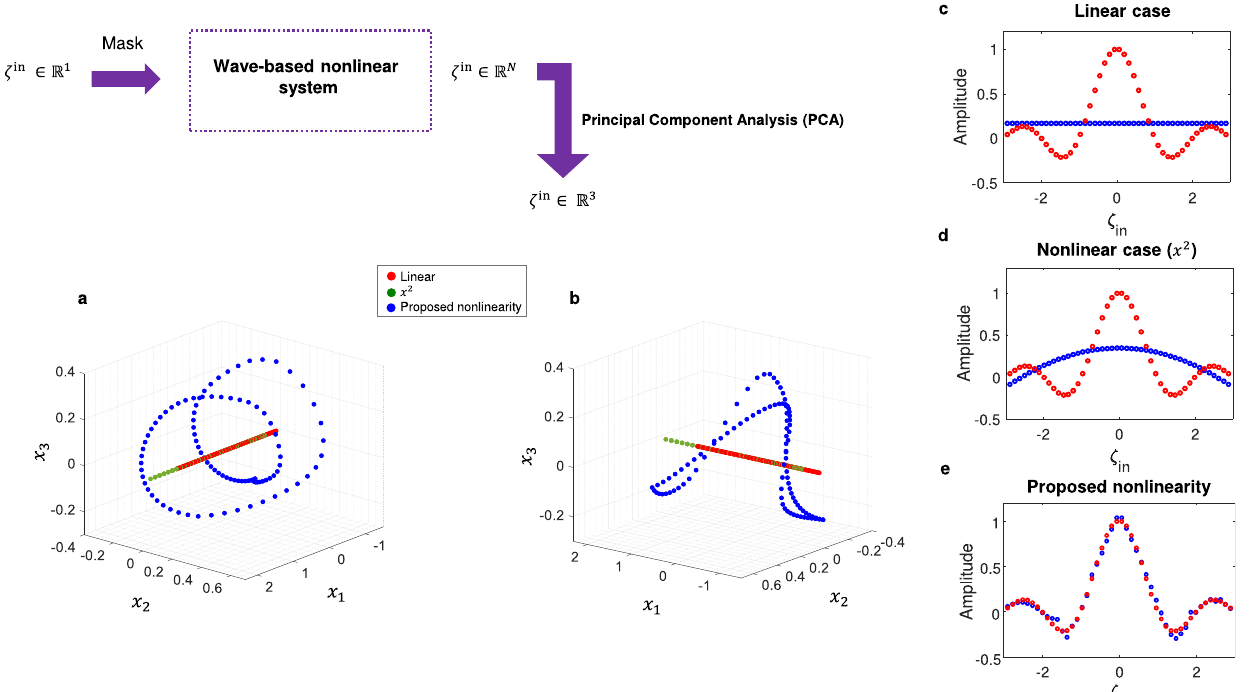
Fig. 4 PCA analysis of the proposed optical kernel. a , b Two different perspectives of Projected data for three different cases: (i) linear case, (ii) square- law nonlinearity ( x 2 ), and (iii) the proposed nonlinearity. c – e sinc ( ζ in ) interpolation results for three aforementioned cases, respectively.